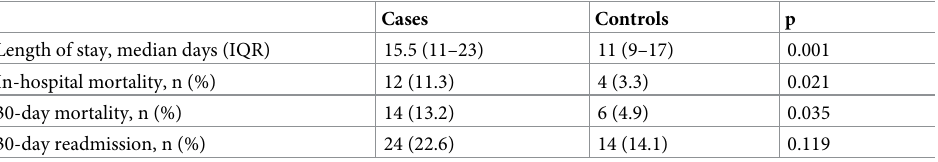
Table 3. Explored outcomes related to the hospital stay in cases and